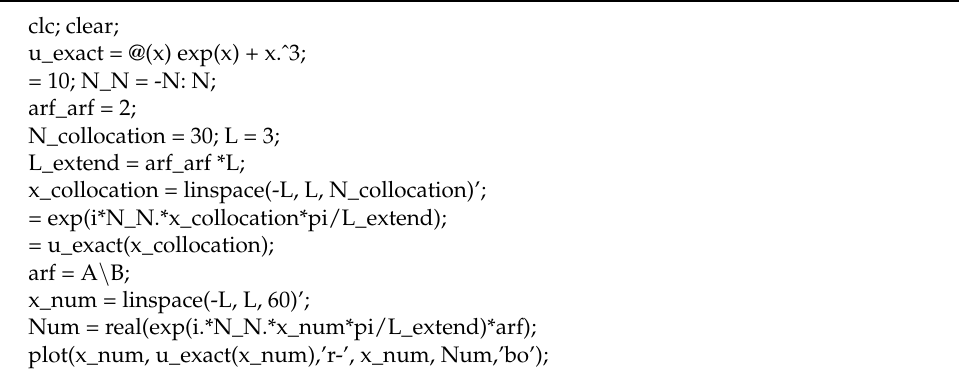
Table 1. MATLAB ®2018a program for modified Fourier series approximation